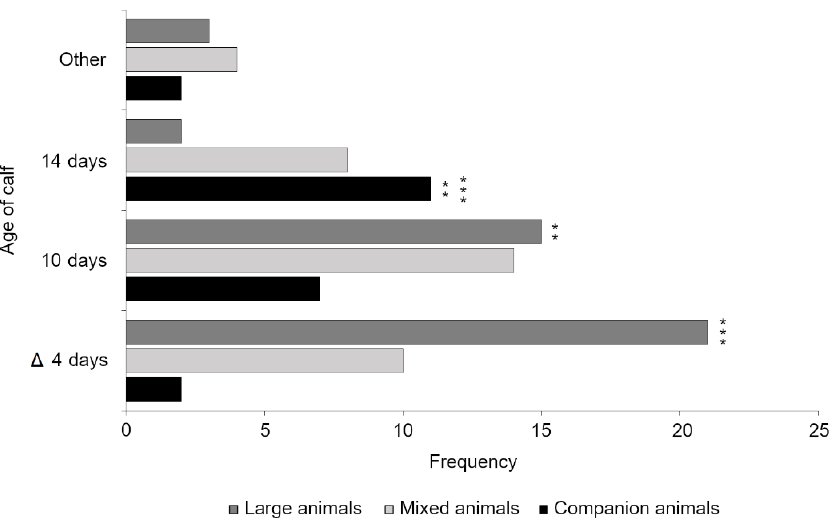
Figure 2. Veterinary opinion on the minimum age at which a young calf is fit for transport. The current legislative minimum age of fitness for transporting young calves has been denoted by a delta symbol. Significant differences between species emphasis following Bonferroni correction (0.05/9 = 0.006) have been marked with a double and triple asterisk ( p = 0.005 and p = 0.001,